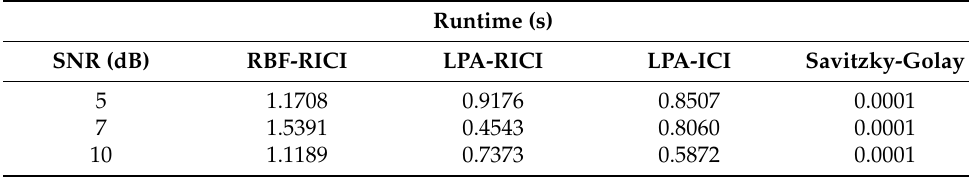
Table 42. Sing signal—Filtering algorithms’